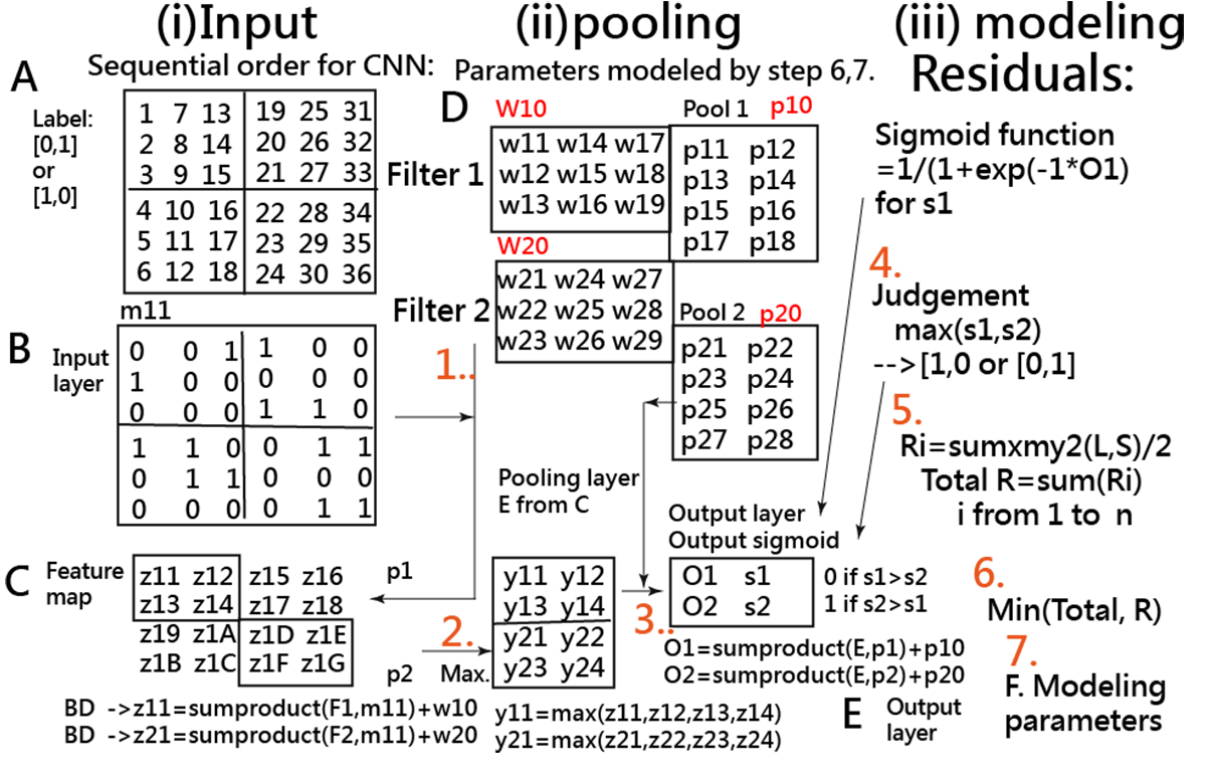
Tasks for Performing Convolutional Neural Network Task 1: Comparison of Prediction Accuracies in Two